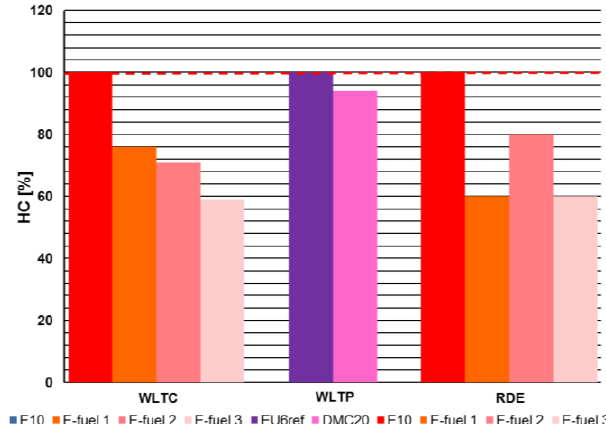
Fig. 4. Changes in the mean HC exhaust emissions of various synthetic fuels compared to conventional petroleum fuels measured in the